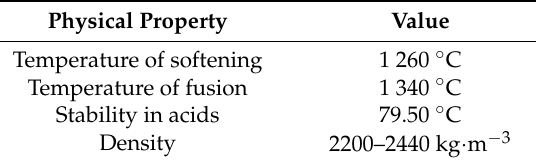
Table 3. Physical properties